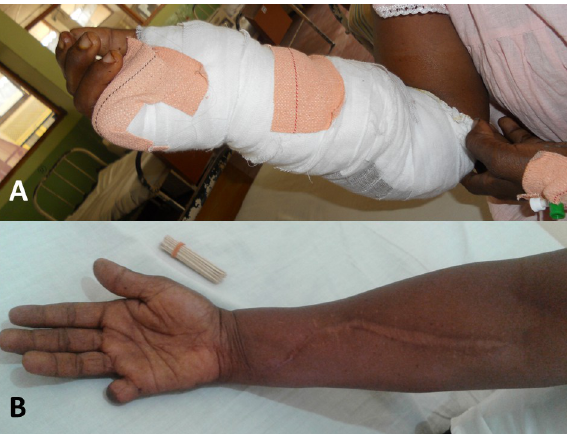
Fig 2. A: Sixty-three-year-old female presented with a hump-nosed viper bite to the right small finger and developed severe local necrosis of the distal phalanx and compartment syndrome involving the forearm. She was managed by decompression fasciotomy, followed by amputation of the two distal phalanxes of the right small finger. B: The same patient after four years with lost phalanxes and fasciotomy scar.